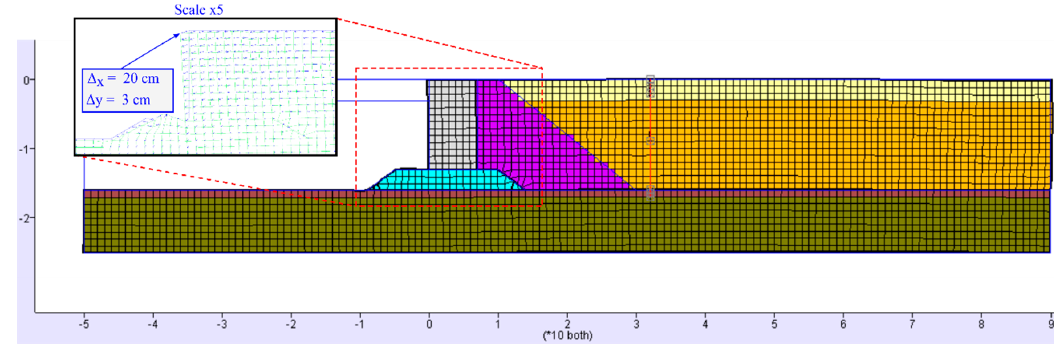
Figure 20. Displacement at the end of shaking (dimension unit in meters). Appl. Sci. 2020 , 10 , x FOR PEER REVIEW